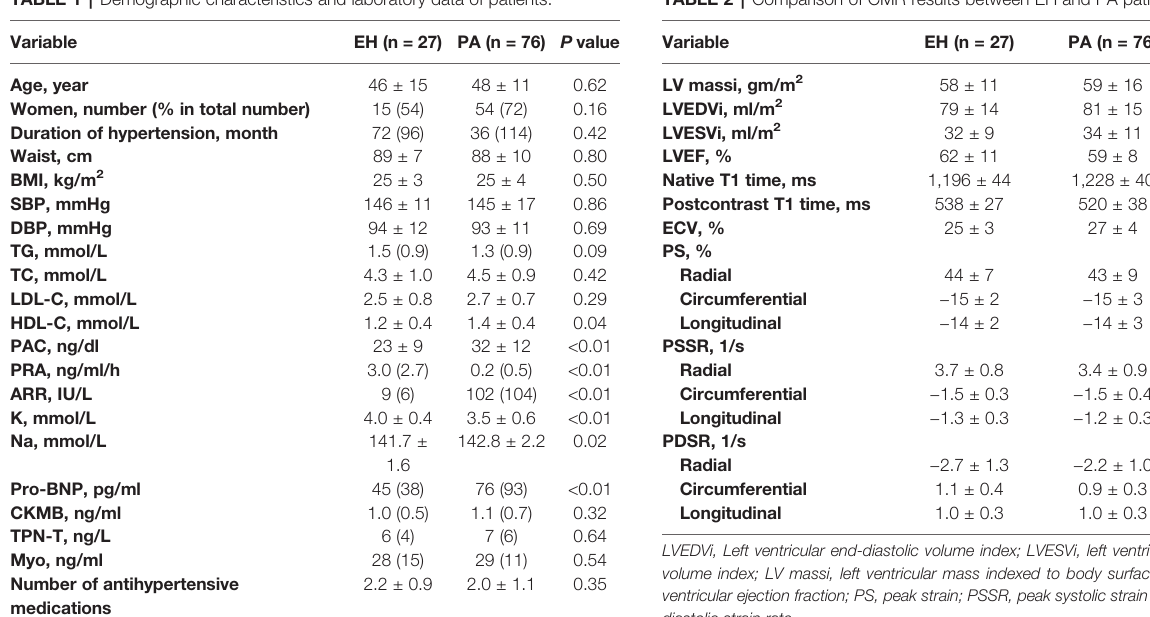
TABLE 2 | Comparison of CMR results between EH and PA patients.